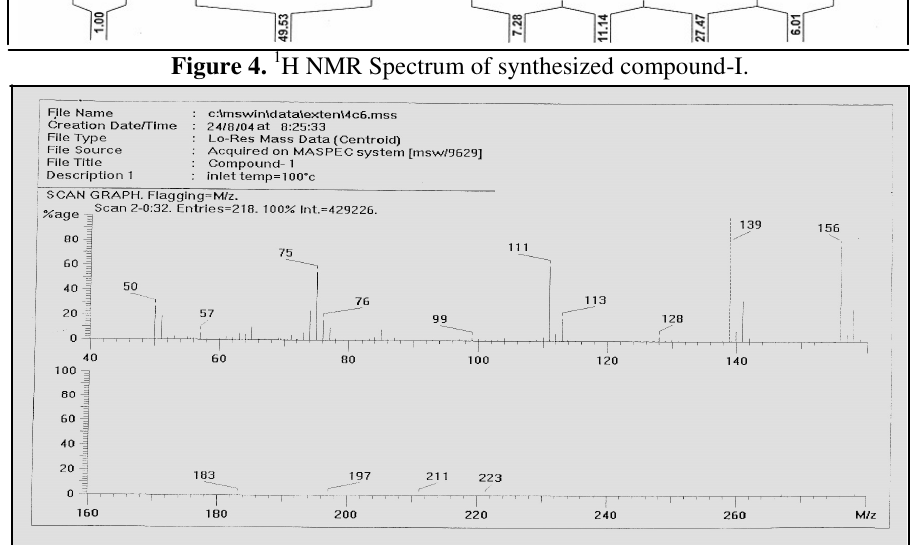
Figure 4. 1 H NMR Spectrum of synthesized compound-I.